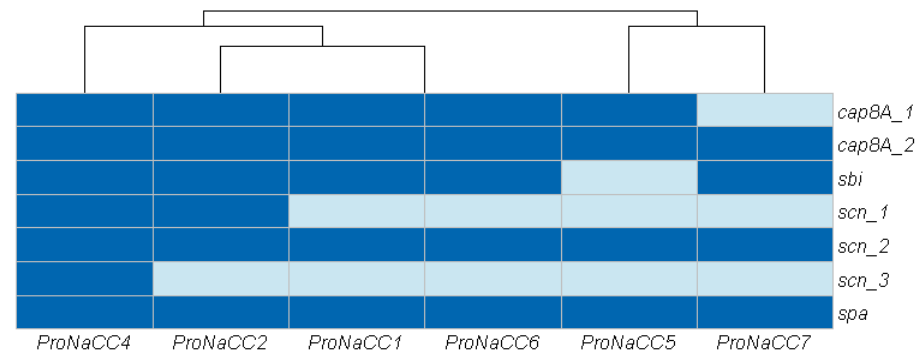
Figure 4. Heat map showing the genes involved in host immune system evasion among the six enterotoxigenic S. aureus strains (dark blue: sequence detected; light blue: sequence not detected).